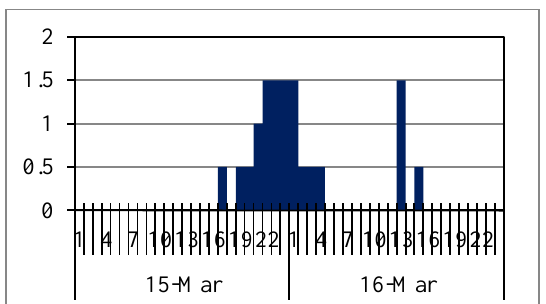
Figure 3. Hyetograph on March 15 to 16 at Iidate village.